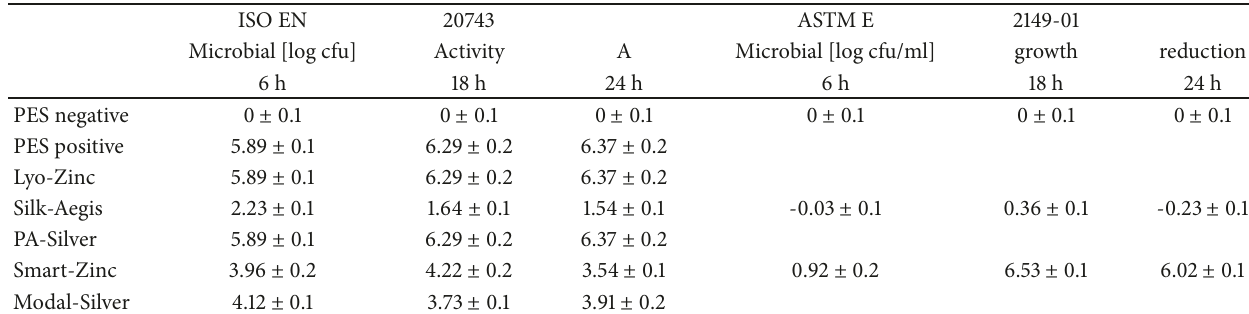
Table 1: Time-trend comparison of antibacterial effectiveness of conventional AD clothes against S. aureus according to the standards ISO 20743 and ASTM E 2149-01. Results depicted as log 10 reduction factors, means of triplicates with SDs. The ISO setup revealed a strong antibacterial effect for the silver-polyamide and the zinc-containing lyocell fabrics. The weakest activity was obtained with the Silk-Aegis sample. Right side: Evaluation of the antibacterial activity of the Silk-Aegis sample via ASTM test. Note failure of activity for the silk